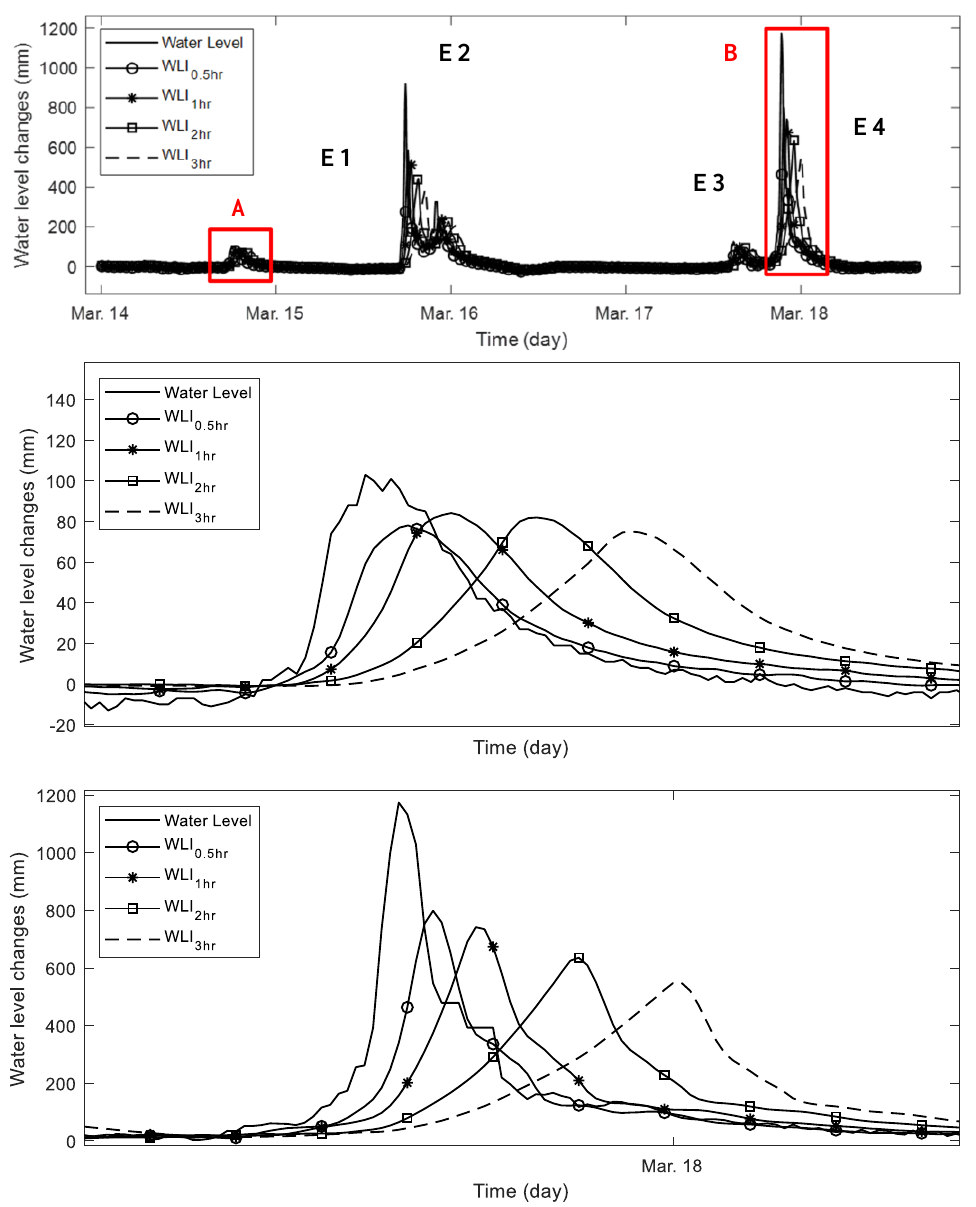
Figure 20. Water level and WLI changes; ( top ) water level change and 4 different WLI curves based on 0.5-, 1-, 2-, and 3-h time windows; ( middle ) the zoomed-in plot of the E1 rainfall event, region A of the top figure; and ( bottom ) zoomed-in plot of the E4 rainfall event, region B of the top figure. The WLIs calculated by different time windows show the more sensitive change in the rapid water level change case (B region) than the relatively moderate water level change case (A region).